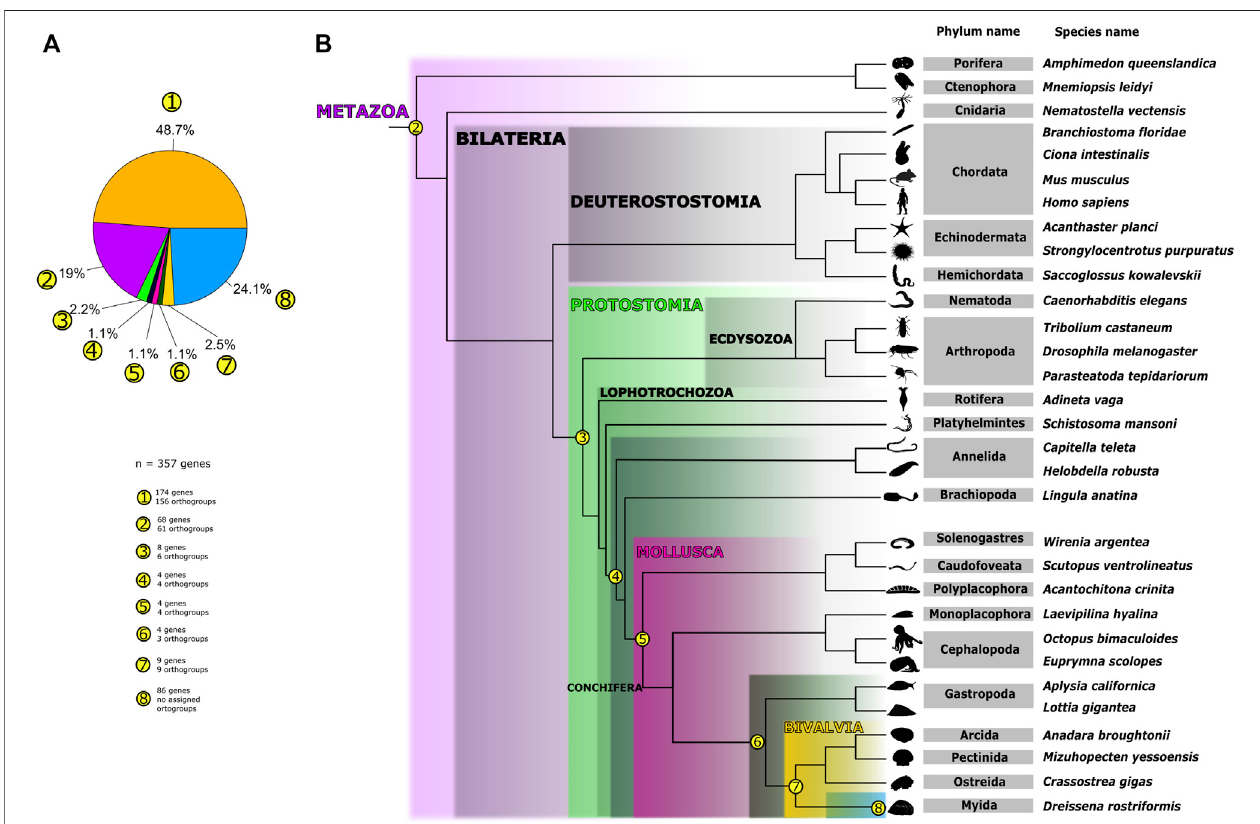
FIGURE 1 | Distribution of orthogroups containing shell fi eld-speci fi c genes from Dreissena rostriformis across Metazoa. (A) Pie chart representing the number of orthogroupsandgenesfoundintherespectivetaxa.Eachsubsetoforthogroups isnumbered(1-8),indicatinghowmany shell fi eld-speci fi cgenesarecontainedineach taxon, together with the total amount of shell fi eld-speci fi c genes analyzed. (B) Dendrogram representing phylogenetic relationships of the sampled species and the presence of orthogroups and genes on each node. Phylogenetic relationships of the sampled species are plotted on a class-level tree based on previous studies (Smith et al., 2011; Laumer et al., 2019; Lemer et al., 2019; Fernández and Gabaldón, 2020; Li et al., 2021). Numbers correspond to those in (A) . Number 1 refers to all shell fi eldorthogroupsthatarerandomlydistributed(i.e.,diverseandwithoutdistinctpattern)amongthesampledmetazoans(48.7%).Numbers2 – 8depicttheshell fi eld genes/orthogroupsidenti fi edfortherespectivenodesinthephylogeny.Node(2)referstothe19%ofallshell fi eldorthogroupspresentinallsampledmetazoangenomes in this study. Node (3) is equivalent to 2.2% of all shell fi eld orthogroups present in sampled protostome organisms. Node (4) corresponds to the 1.1% of orthogroups presentinthesampledorganismsclassi fi edasLophotrochozoa.Node(5)referstoallshell fi eldorthogroupspresentexclusivelyinthesampledmollusks(1.1%).Node(6) representsall shell fi eldorthogroups (1.1%) present in thegastropod and bivalve genomessampled.Node(7)depicts allshell fi eld orthogroups (2.5%) present inbivalve genomesanalyzedhere.Node(8)representsall D.rostriformis -speci fi cshell fi eldgenesthatcouldnotbeassignedtoanyorthogroup.Speciessilhouetteswereobtained from www.phylopic.org and are either licensed under Creative Commons Attribution 3.0 Unported or are available under public domain.